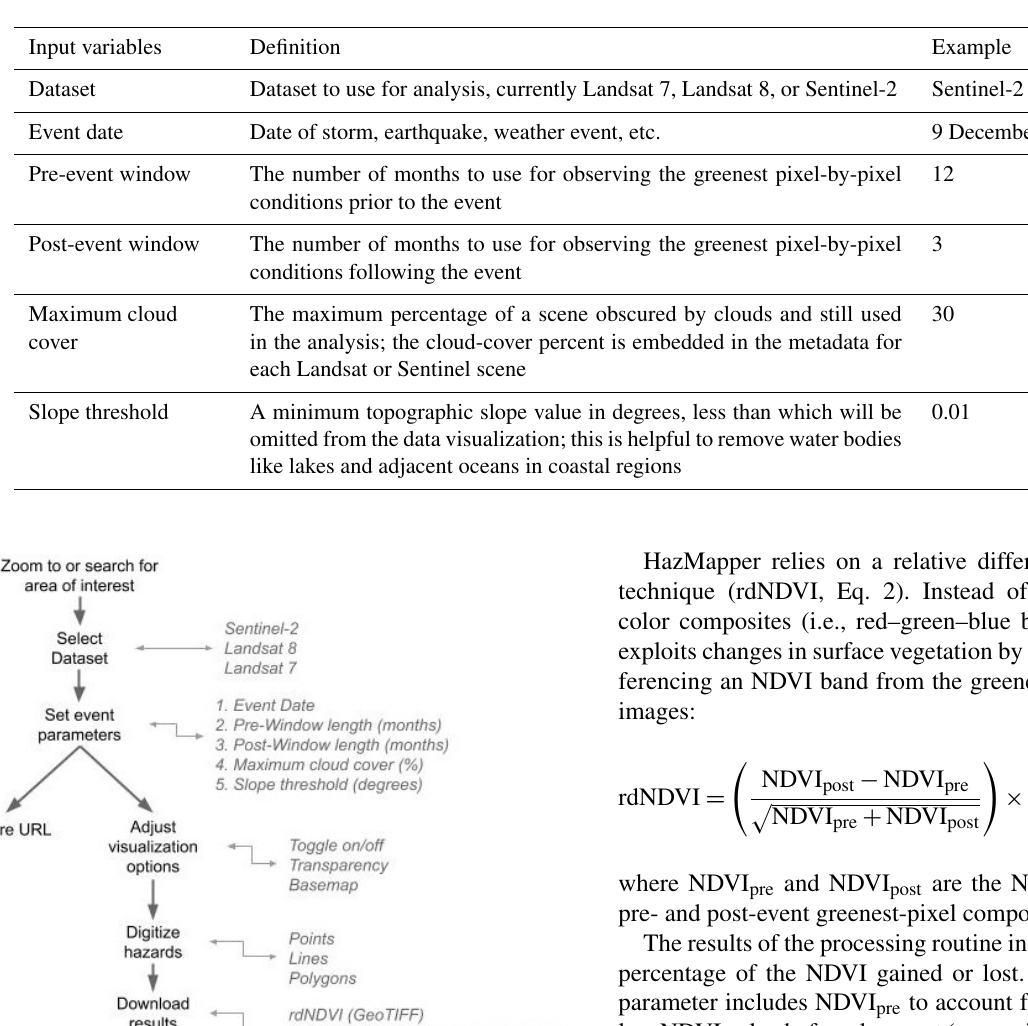
Table 1. HazMapper input variables, definitions, and examples.